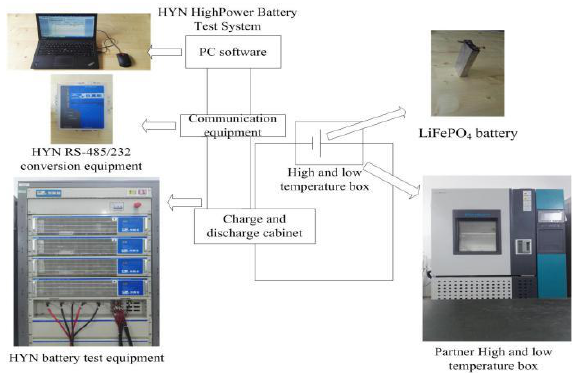
Figure 9. Physical map of experimental test platform.